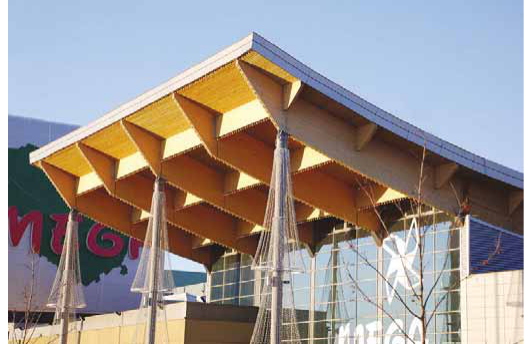
Fig. 31. Glued wooden constructions in shopping center “Mega”, Kaunas, archit. office “Chapman